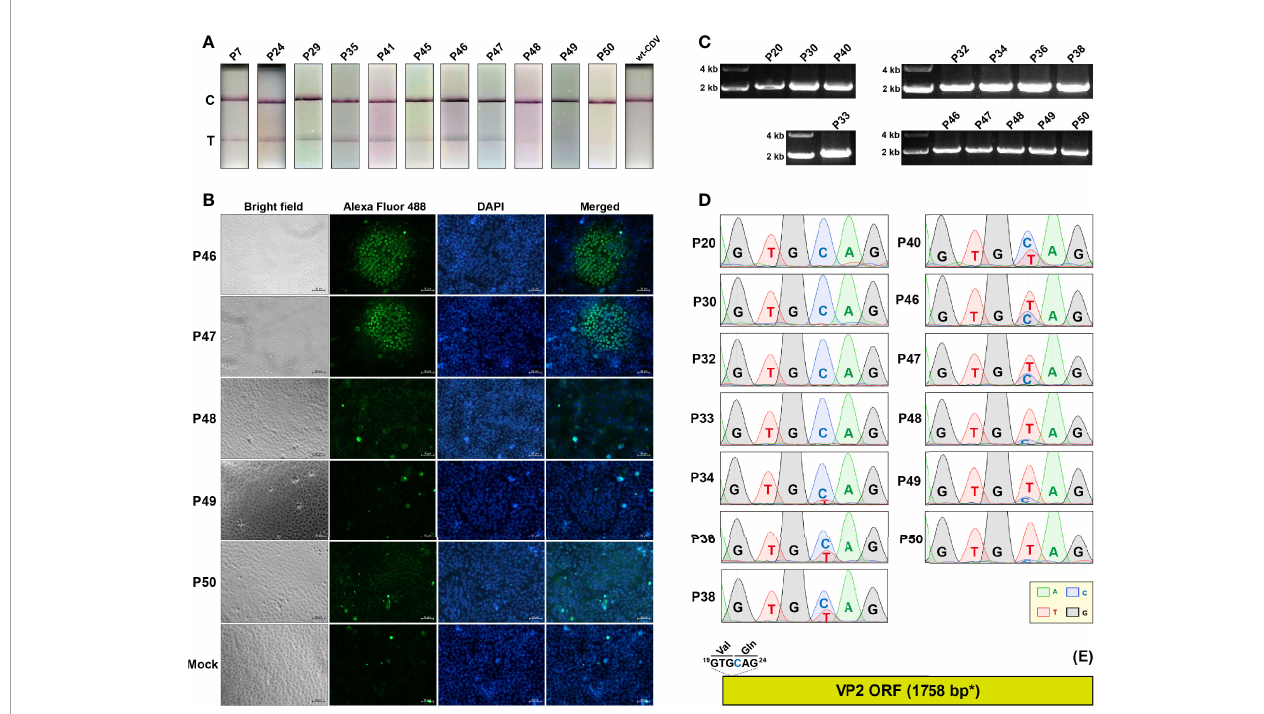
FIGURE 2 | Genetic stability of VP2 sequence during 50 serial passages in VDS cells. Test strip-based detections of cell cultures independently inoculated with rCDV-VP2 progenies (A) . T, test; C, control. IFAs of VP2 expression in VDS cells inoculated with rCDV-VP2 progenies (B) . VP2 MAb (primary antibody) and Alexa Fluor ® 488 conjugate (secondary antibody) are used for the IFA. RT-PCR analyses of rCDV-VP2 progenies using FP/RP (C) . Sanger sequencing chromatograms of RT-PCR products of rCDV-VP2 progenies (D) . Only the 6-nt-long sequence, nt 19 to 24 in VP2 ORF, is shown. The 19 GTGCAG 24 fragment in VP2 ORF (E) . “ GTG ” and “ CAG ” encode valine and glutamine, respectively. *The VP2 ORF contains one extra “ 4 GCG 6 ” to meet the criteria of Kozak consensus